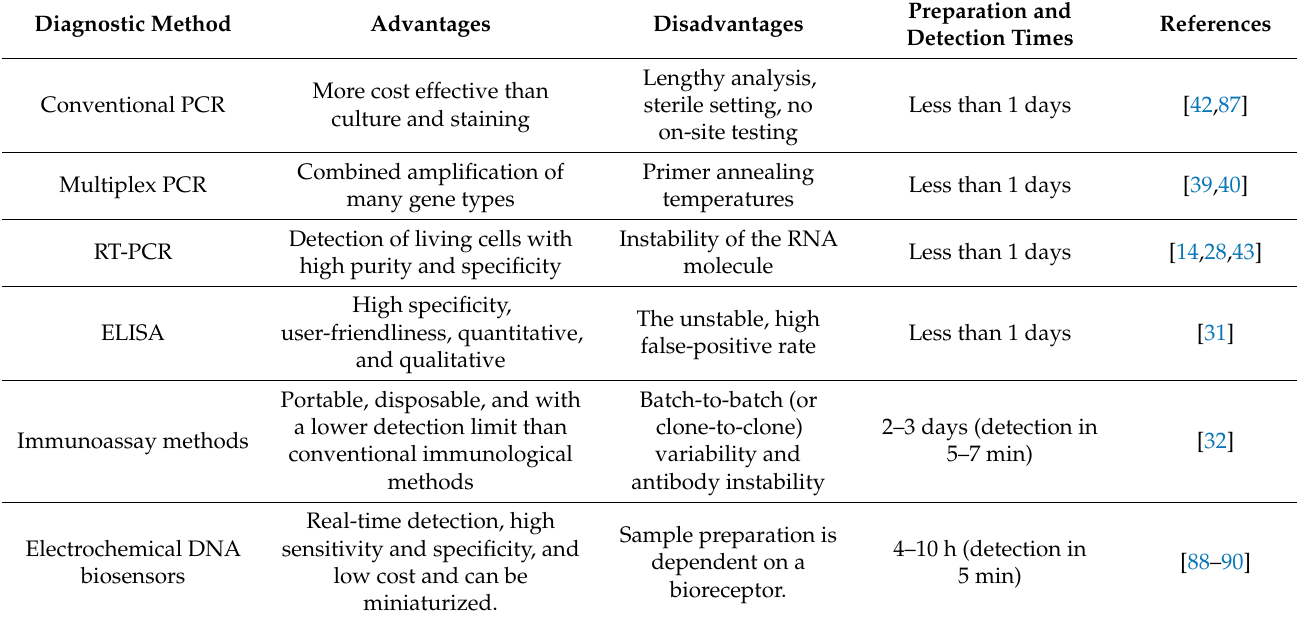
Table 2. Summary of the advantages and disadvantages of detecting